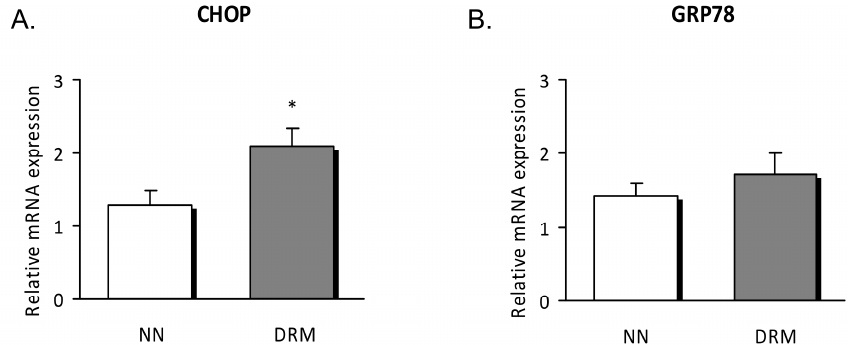
Figure 4. Relative mRNA expression in leukocytes of NN and DRM subjects. ( A ) CHOP gene expression relative to GAPDH gene expression in NN vs DRM patients. ( B ) GRP78 gene expression relative to GAPDH gene expression in NN vs DRM patients. * p < 0.05 vs. NN group using an unpaired t -test. NN: Normonutrition; DRM: Disease-related malnutrition.